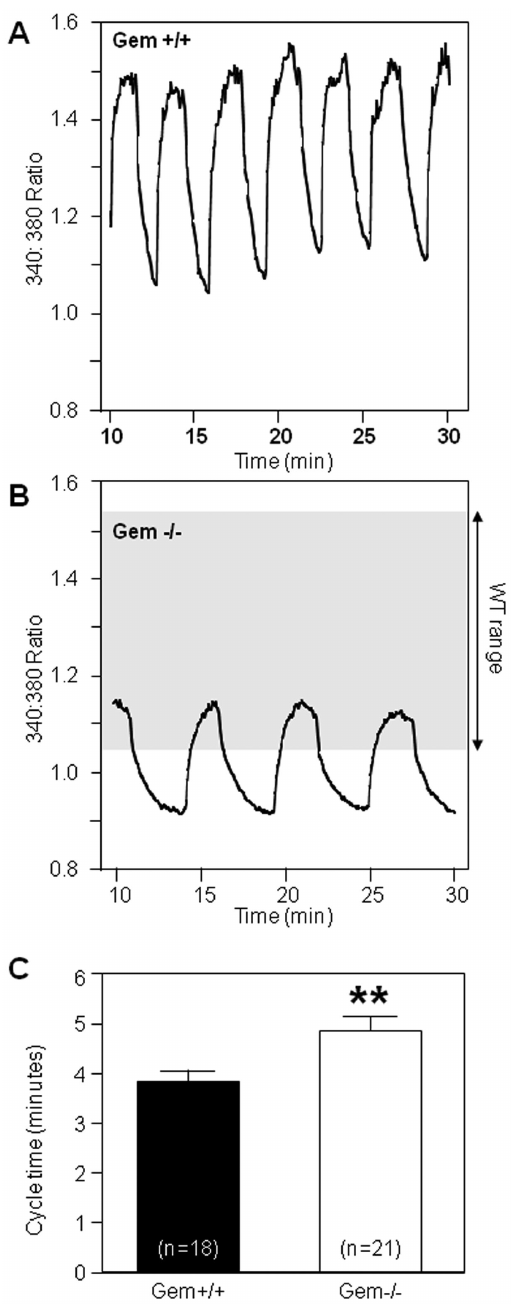
Figure 4. Calcium oscillations are slower in Gem 2 / 2 mice. A ) Wild-type mice (Gem + / + ) have normal amplitude and frequency of calcium oscillations after exposure to 11.1 mM glucose. B ) In contrast, Gem 2 / 2 islets display smaller amplitude oscillations of lower frequency. C ) Oscillation cycle time was slower in Gem-null islets. Error bars indicate 6 1SEM. **=p ,